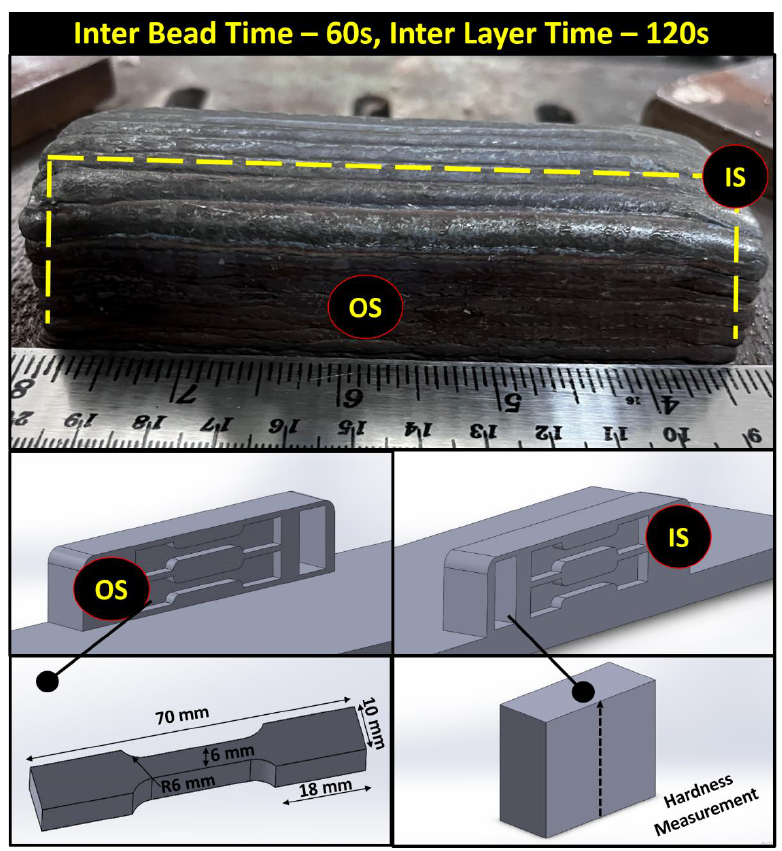
Figure 6. The bulk fabricated thick walls and their corresponding samples for mechanical and microstructural characterization made using the CMT − based WAAM process.